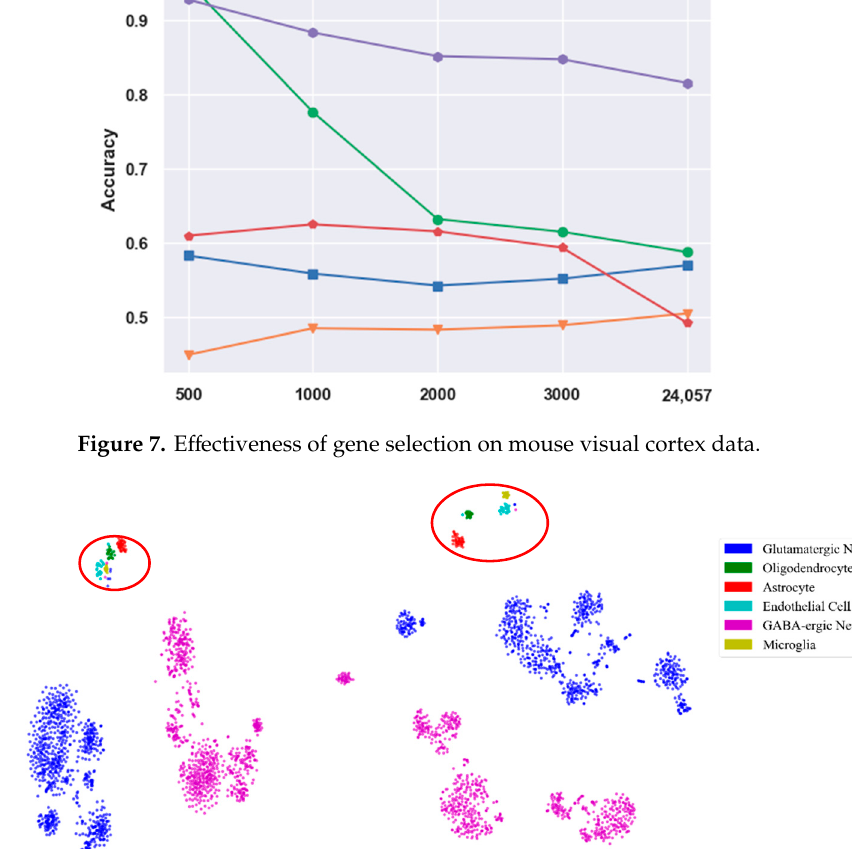
Figure 7. Effectiveness of gene selection on mouse visual cortex data.